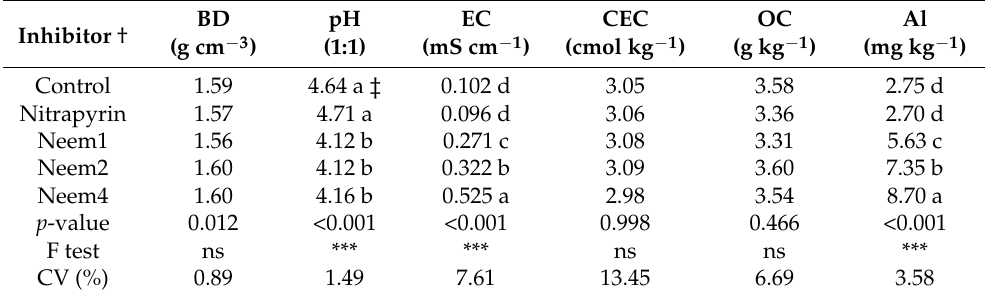
Table 7. Selected soil properties at lettuce harvest as affected by different nitrification inhibitors. Inhibitor † Control